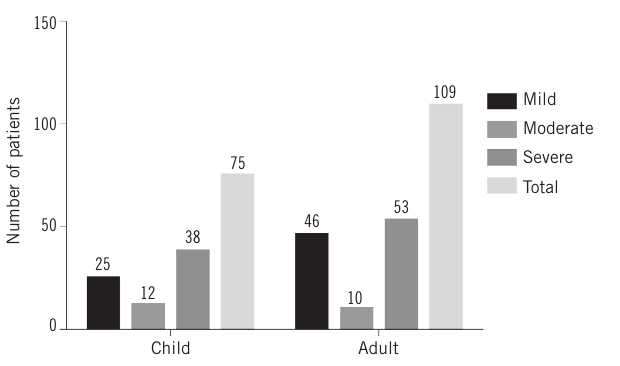
figurE 2 − Distribution of the three levels of severity of hemophilia according to age group